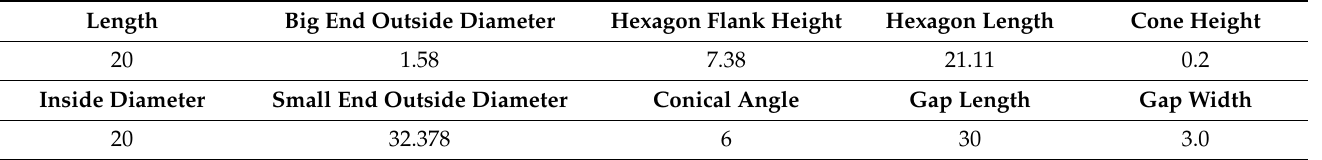
Figure 1. Tray dimensions. Unit in the figure: mm. Table 2. Dimensions of nuts (Units in the table: mm).